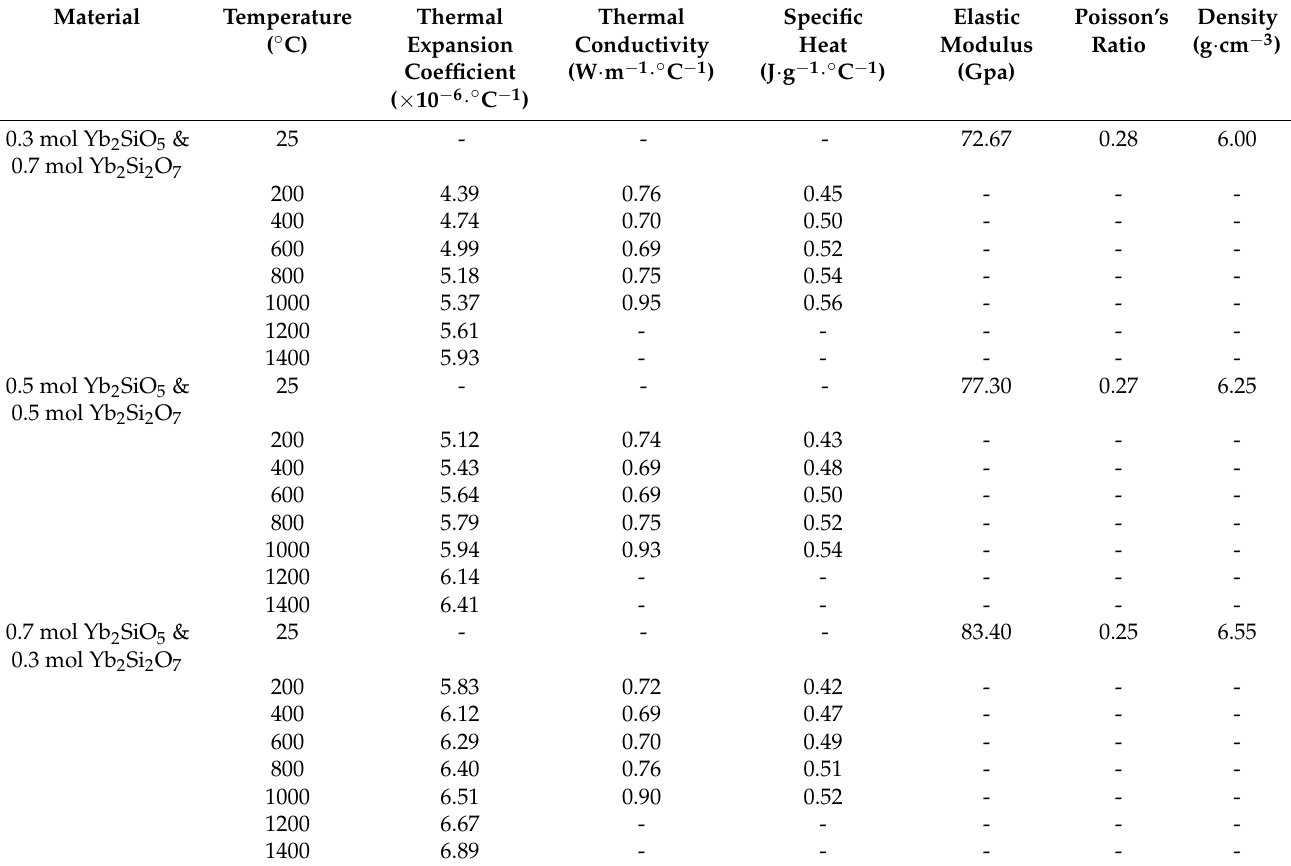
Table A2. Thermophysical parameters of ytterbium silicate composite